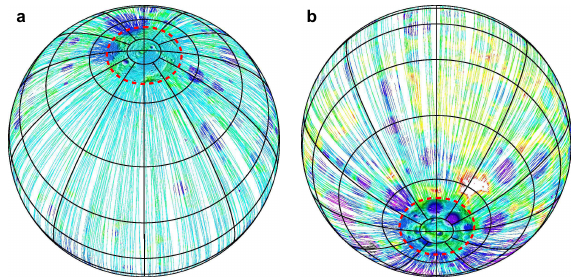
Figure 1. The pole-to-pole spanning LOLA tracks intersecting both DTMs (red circles) are shown in a general perspective view with grid lines drawn in 30 ◦ longitudinal and 5 ◦ latitudinal spacing and arctic circle at 88.5 ◦ N/S. Note that only 10% of the pole-to-pole spanning LOLA tracks are shown for reasons of visualization. (a) Northern hemisphere with north pole DTM. (b) Southern hemisphere with south pole